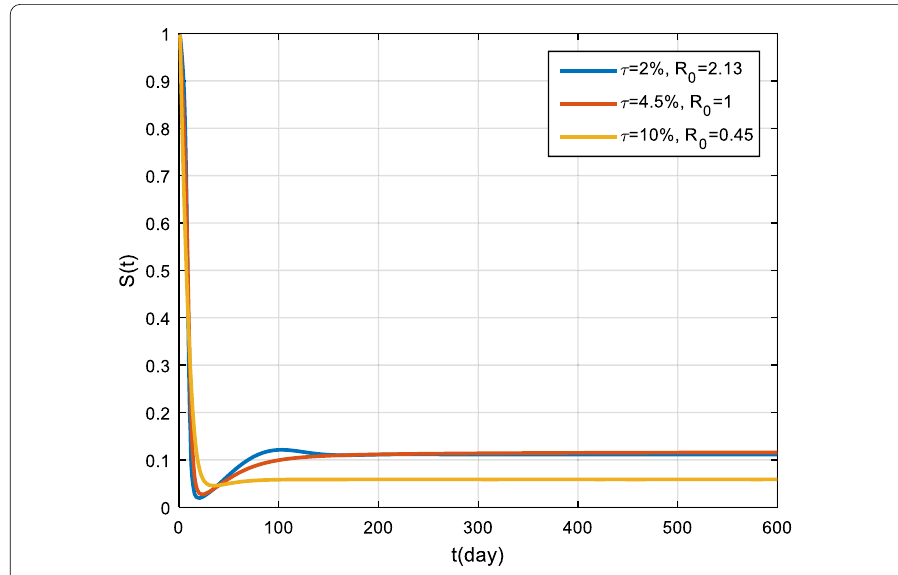
Figure 14 Variation in the number of suspected population for different values of τ